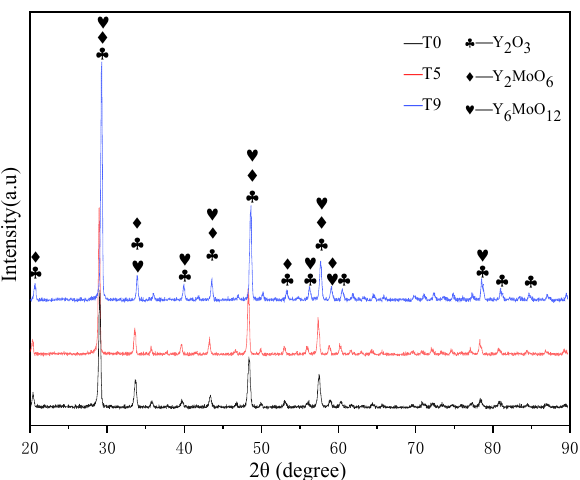
Figure 5. XRD patterns of Y 2 O 3 coated graphite (T0) and laser micromelted Y 2 O 3 coated graphite (T5) and (T9).